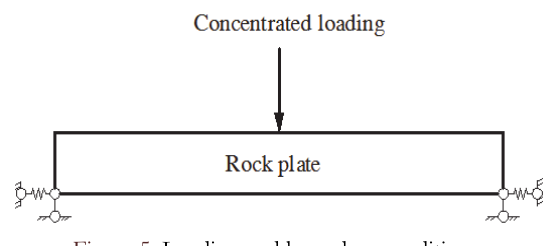
Figure 4: The computational model and its grids. Figure 5: Loading and boundary conditions.